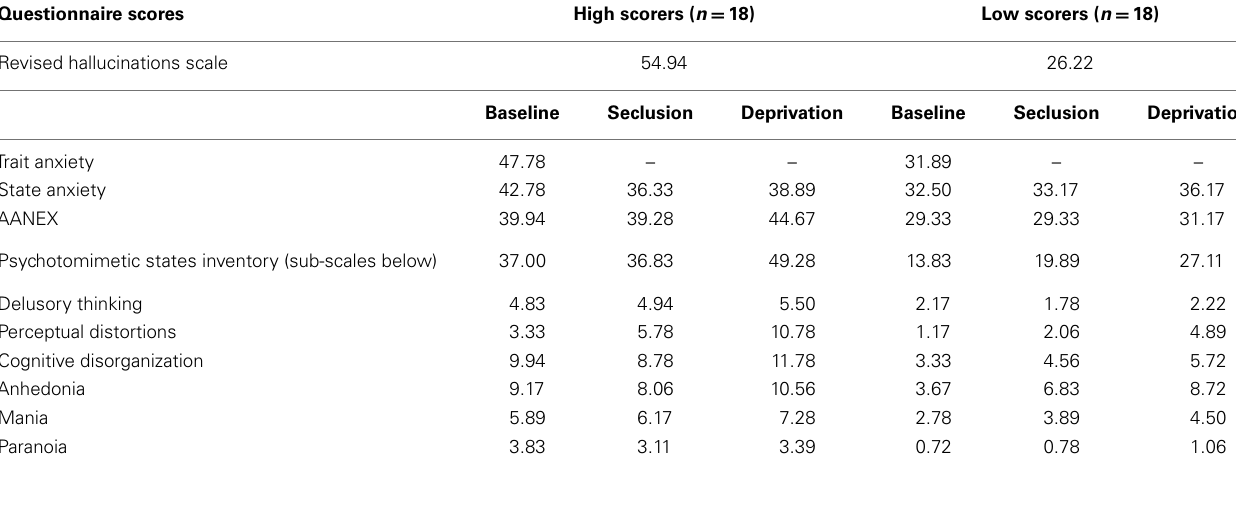
Table 1 | Questionnaire mean scores for high and low hallucination-prone groups by condition . Questionnaire